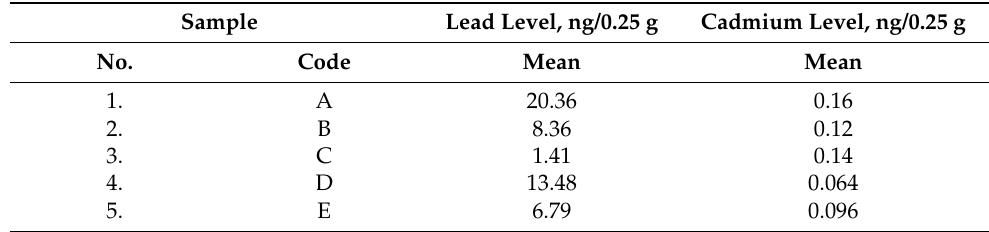
Table 2. HMI levels in the analyzed samples (ointment, ng/0.25 g) one-time administration.